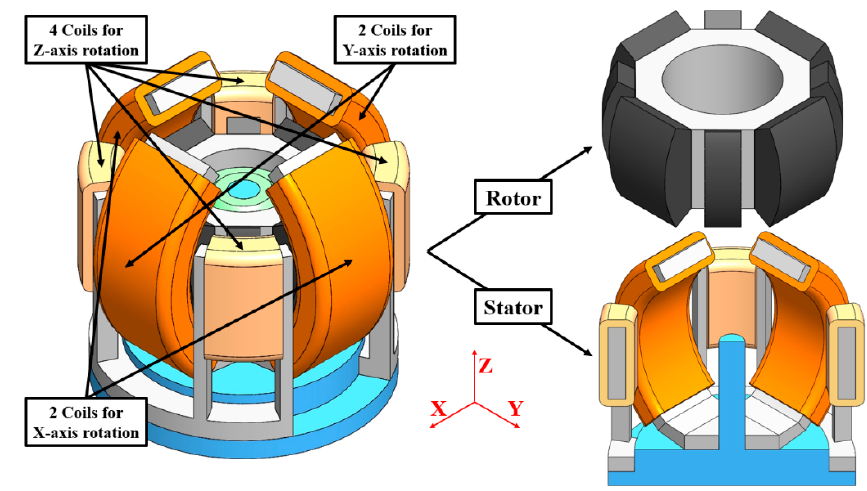
Figure 1. Basic structure of original 3-DOF spherical motor.